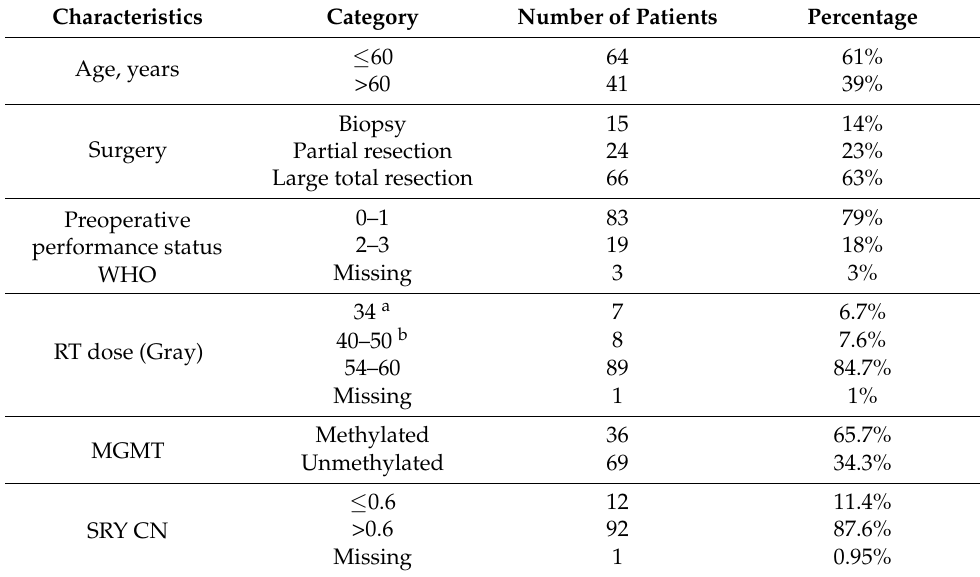
Table 1. Clinicopathological data of male glioblastoma (GBM) patients from southeast